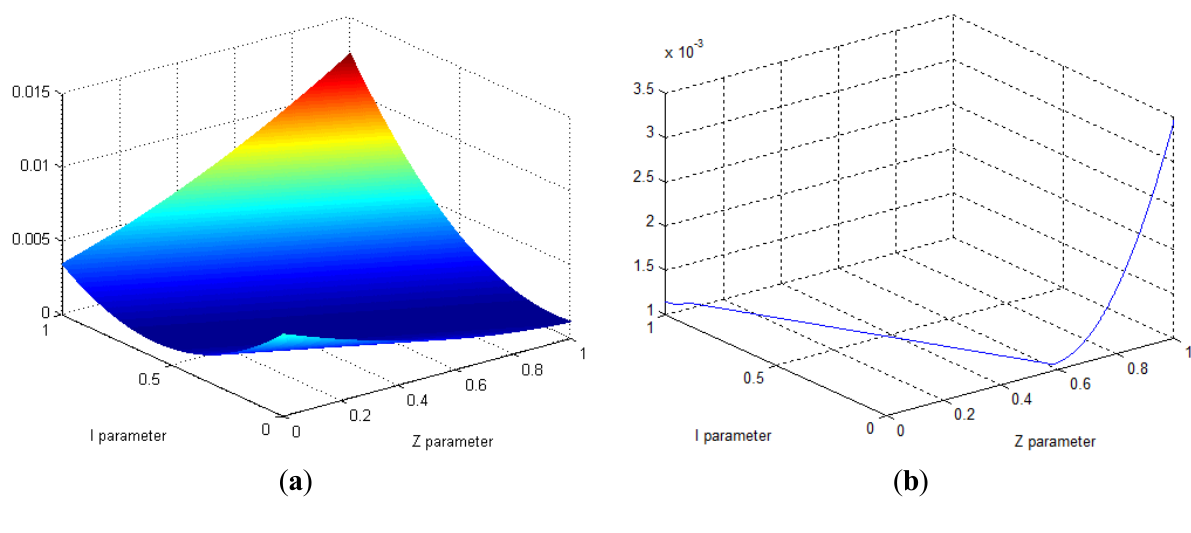
Figure 3. Reactive power results for the 344th transformer bank on winter evenings: ( a ) errors obtained from the reactive objective function; ( b ) minimum reactive objective function errors according to the variation in q . Z